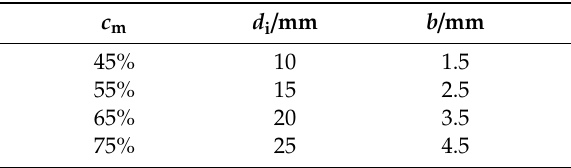
Table 5. Parameters of the improved ball screw.